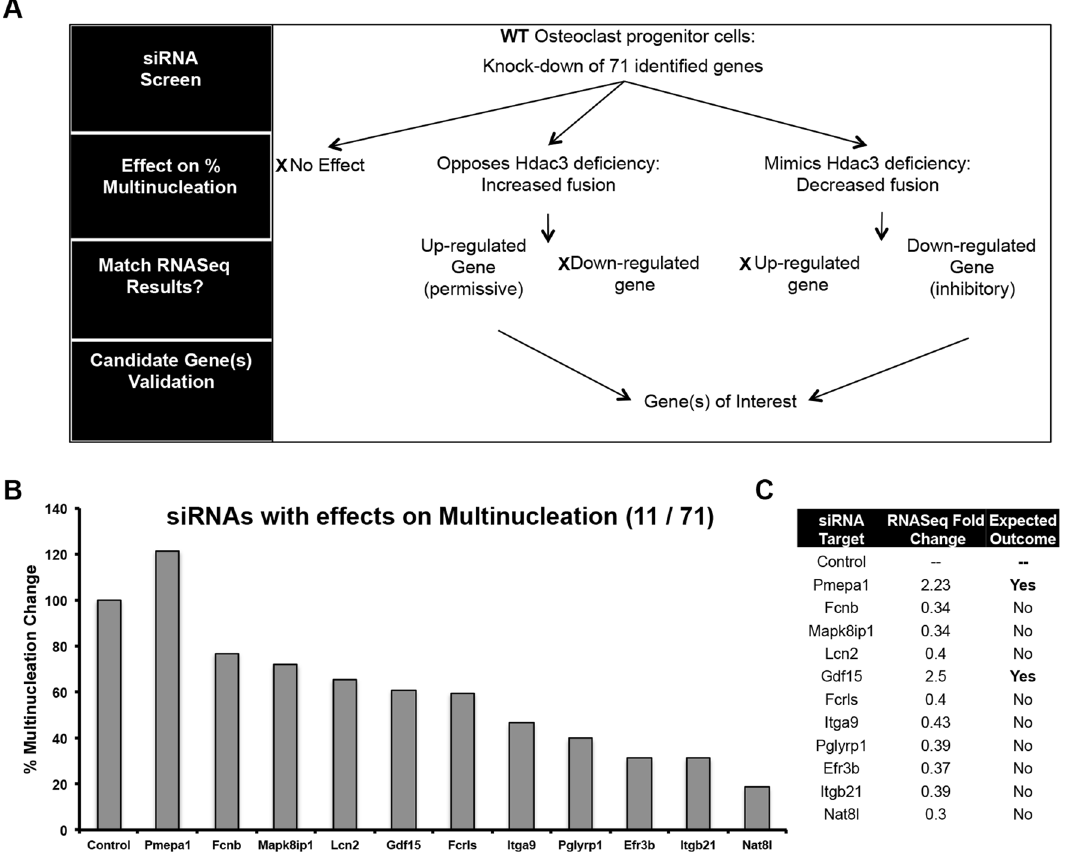
Figure 5. SiRNA-based screen to identify Hdac3 effector genes. A siRNA-based screen was performed as depicted in (A). Points where differentially expressed genes were excluded from the screen are noted with an X. Bone marrow macrophages were collected from wild type 6-week-old female mice. Cells were transfected with a siRNA targeting a differentially expressed gene or control siRNA on day 1 of osteoclast differentiation. Cells were then TRAP stained on day 4 and the targets that affected osteoclast multinucleation were identified ( B ). Genes that meet screening criteria outlined in ( A ) are highlighted ( C ).